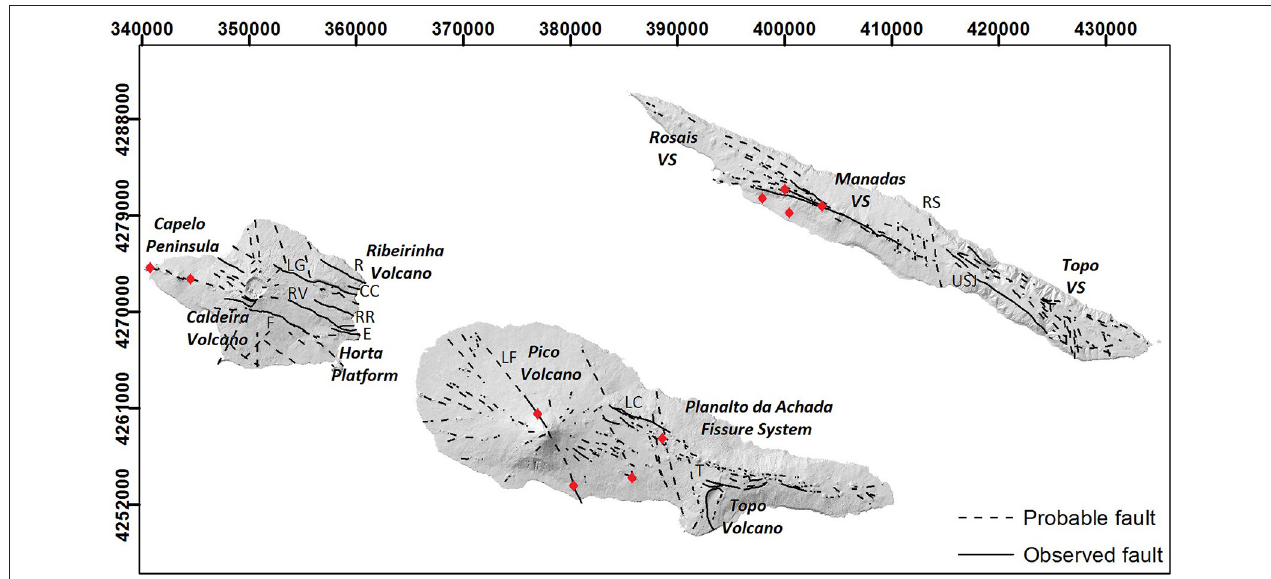
FIGURE 2 | Faial, Pico, and São Jorge digital elevation models with the identification of the volcanic systems and the main tectonic structures. Legend of the tectonic structures: Faial Island: LG, Lomba Grande; R, Ribeirinha; CC, Chã da Cruz; RR, Ribeira do Rato; RV, Rocha Vermelha; E, Espalamaca; F, Flamengos; Pico Island: LF, Lomba de Fogo-S. João; LC, Lagoa do Capitão; T, Topo; São Jorge Island: RS, Ribeira Seca; USJ, Urze-São João. VS, Volcanic System. The red diamonds represent the approximate locations of the onshore historical volcanic centers (tectonic structures modified from Madeira and Brum da Silveira, 2003).